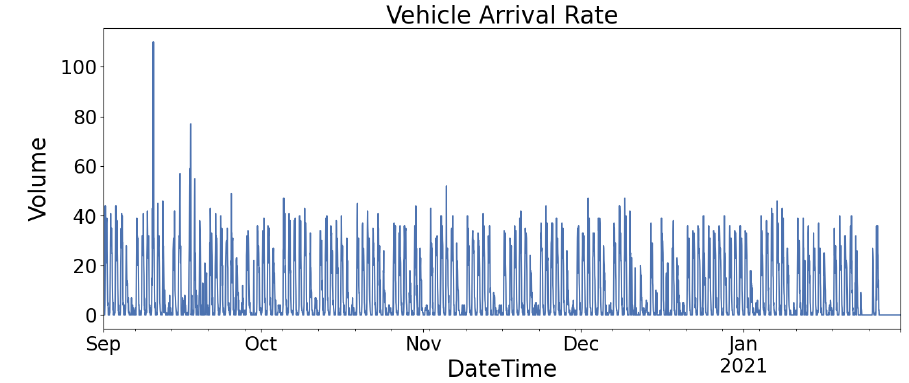
Figure 2. Vehicle arrival rate of Location A from September 2020 to January 2021.